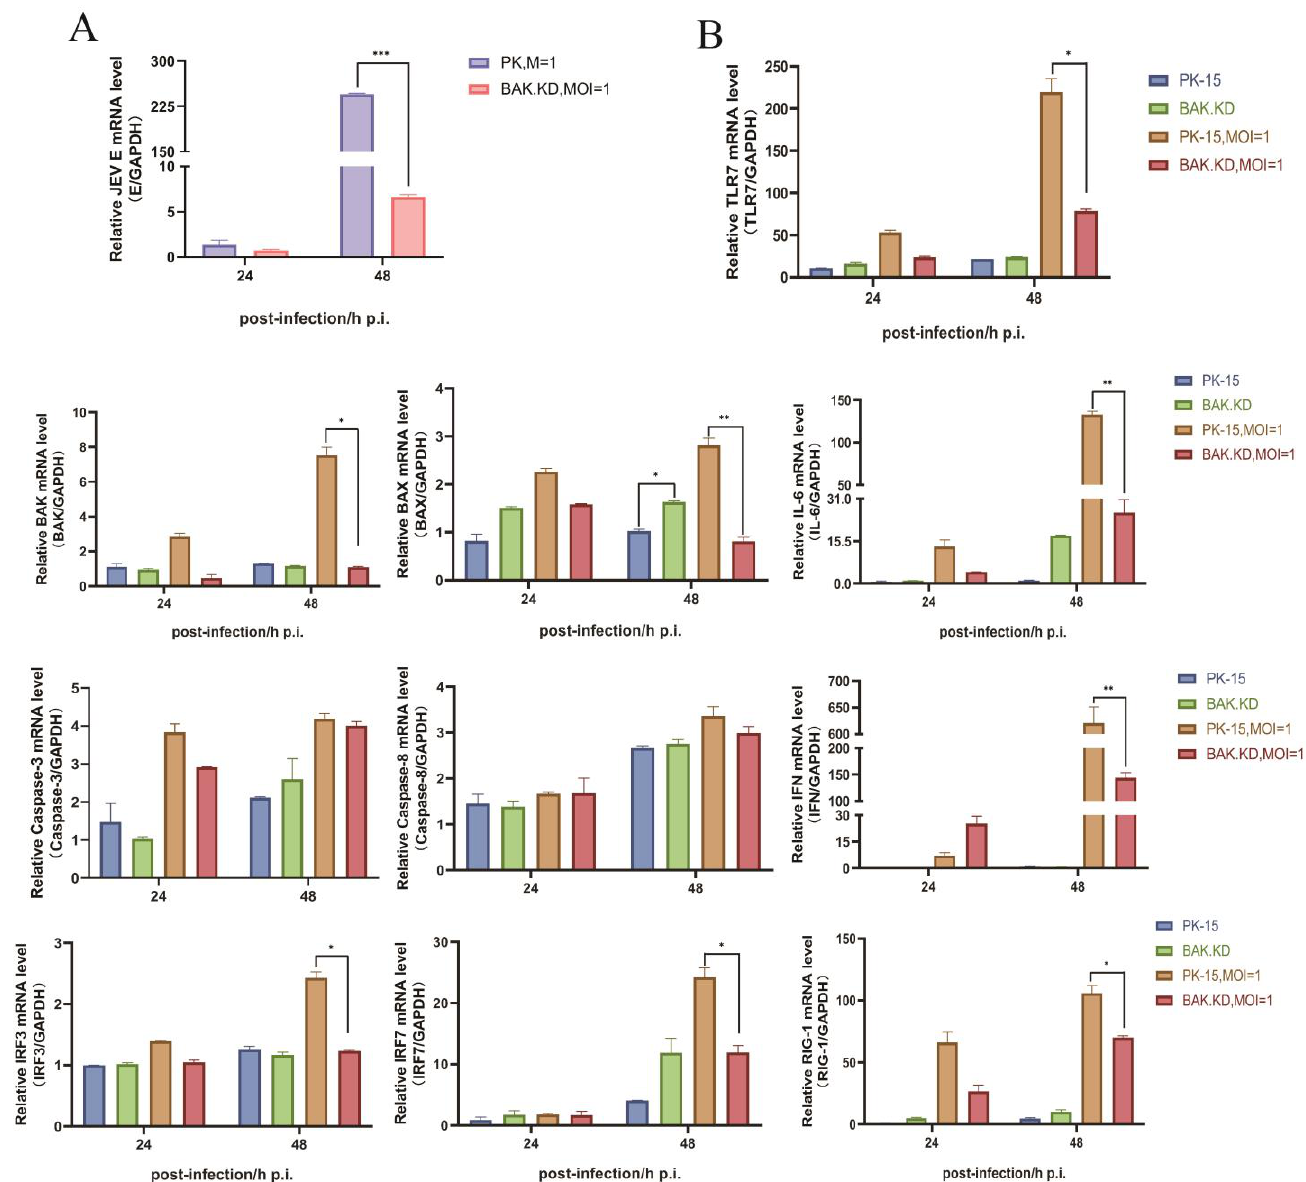
Figure 2. BAK-mediated cytokine transcription levels were significantly increased in the late stage of JEV proliferation. ( A ) JEV-infected normal cells and BAK.KD cells were collected, the total RNA was extracted and reverse transcribed into cDNA, and the expression of the intracellular E gene was measured at 24 and 48 h. ( B ) Normal cells and BAK.KD cells were also quantitatively determined by the fluorescence quantitative determination of JEV-induced changes in the transcriptional levels of inflammatory cytokine genes, with GAPDH as the reference gene. Three independent replicates were set for each experiment, and the experimental results were averaged for processing. * ( p < 0.05), ** ( p < 0.01), *** ( p < 0.001), and ns (not significant).